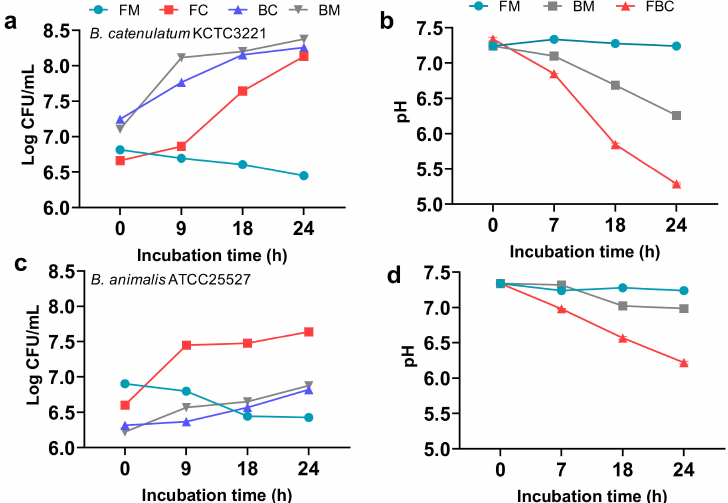
Figure 3. Changes in the viable cell number and pH of cultures of F. prausnitzii and B. catenulatum KCTC 3221 or B. animalis ATCC 25527 in YCFOS medium. Data for F. prausnitzii in monoculture or co-culture with B. catenulatum KCTC 3221 ( a,b ) or B. animalis ATCC 25527 ( c,d ) in YC medium supplemented with FOS are shown. Samples were analyzed at the indicated time intervals. Cell numbers were determined by viable counts, as CFU / mL, after plating on LYBHI agar ( a , c ). The pH changes are plotted in ( b , d ). The data are presented as the mean ± standard deviation ( n = 3). FM, F. prausnitzii in monoculture;